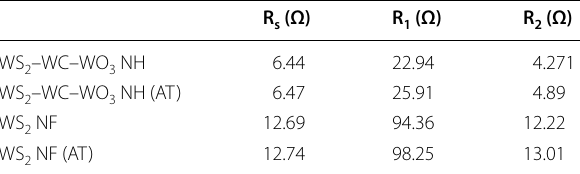
Table 1 The fitting values of charge-transfer resistances (Rs), the resistance between the electrocatalysts and solution (R1), and the resistance between the electrocatalysts and GCE (R2) of samples R s (Ω) R 1 (Ω)